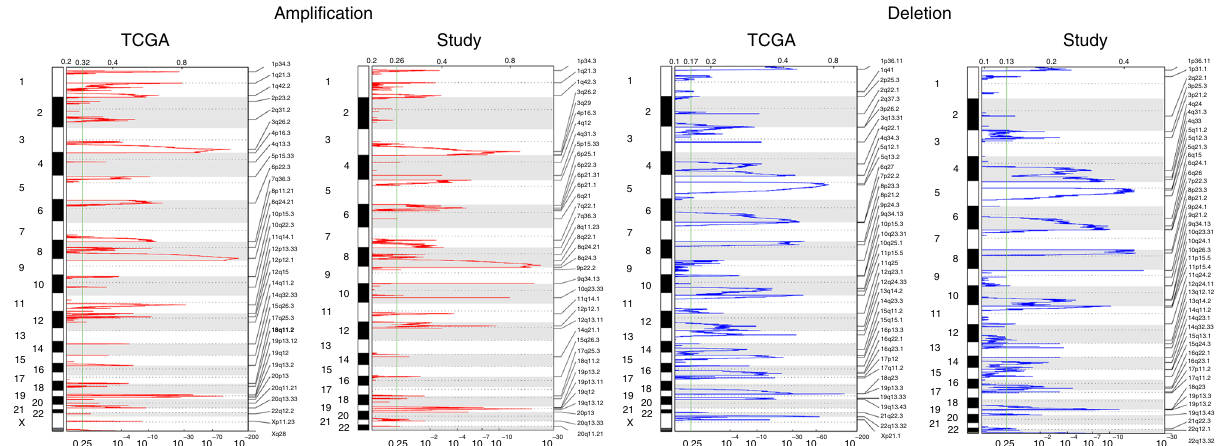
Fig. 6 TCGA features of study samples using focal copy number alterations. Focal copy number alterations in study samples compared to the TCGA data